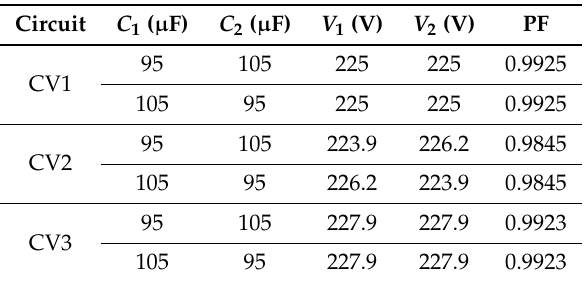
Table 4. Comparison results with capacitors variation.